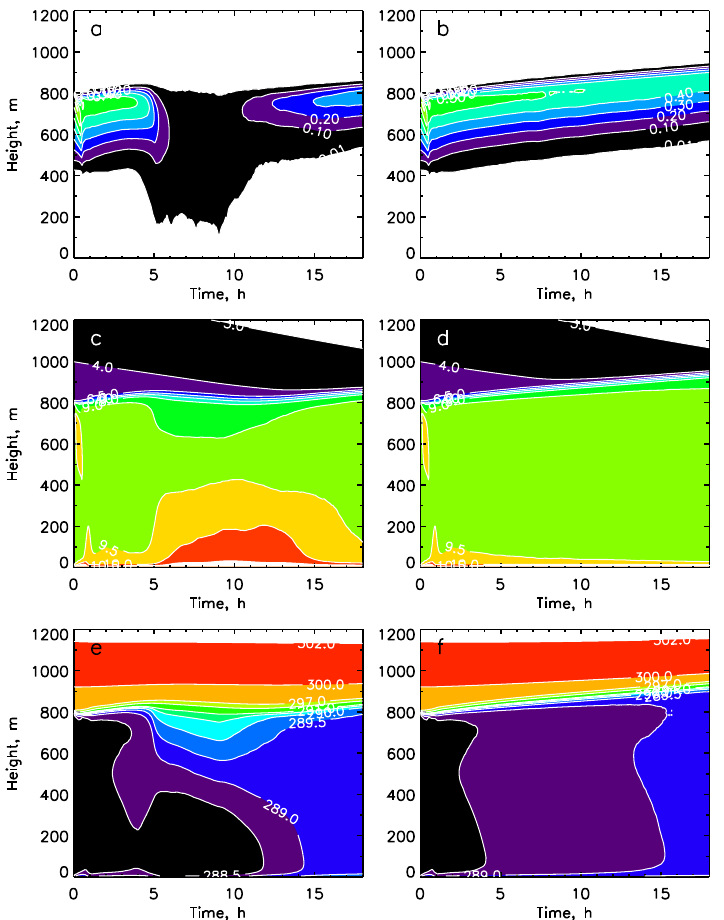
Figure 5. Domain average profiles of (a) and (b) liquid water mixing ratio q c , (c) and (d) total water mixing ratio q t , and (e) and (f) liquid water potential temperature θ l . Left column: control case with minimum N = 5mg − 1 ; right column: N = 90mg − 1 throughout the simulation. Drizzle results in a drying of the cloud layer and a moistening of the surface (c) . The drizzling period is characterized by poor average vertical mixing. The drizzling system eventually recovers to a well-mixed state, although surface moisture